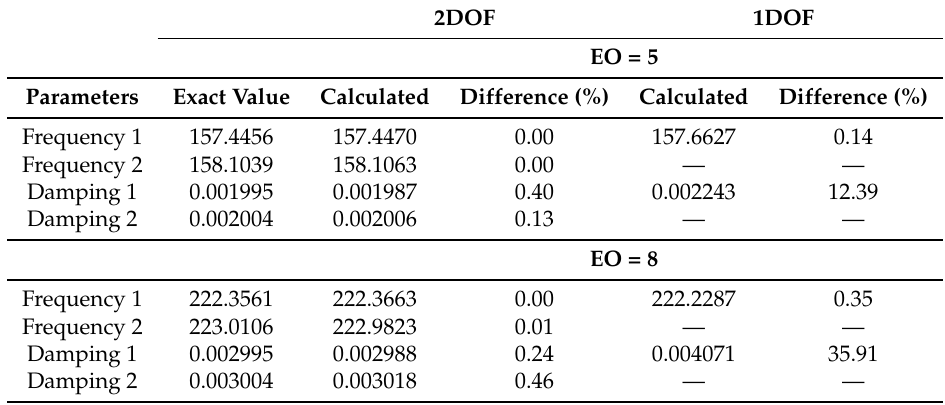
Figure 11. Comparison of non-dimensional amplitudes obtained by different fitting methods for SD = 0.10, ( a ) EO = 5, ζ 1,2 = 0.002, ( b ) EO = 8, ζ 1,2 = 0.003. Table 3. Comparison of vibration parameters identified by 2DOF and 1DOF models with the exact values for EO = 5, 8 and SD =